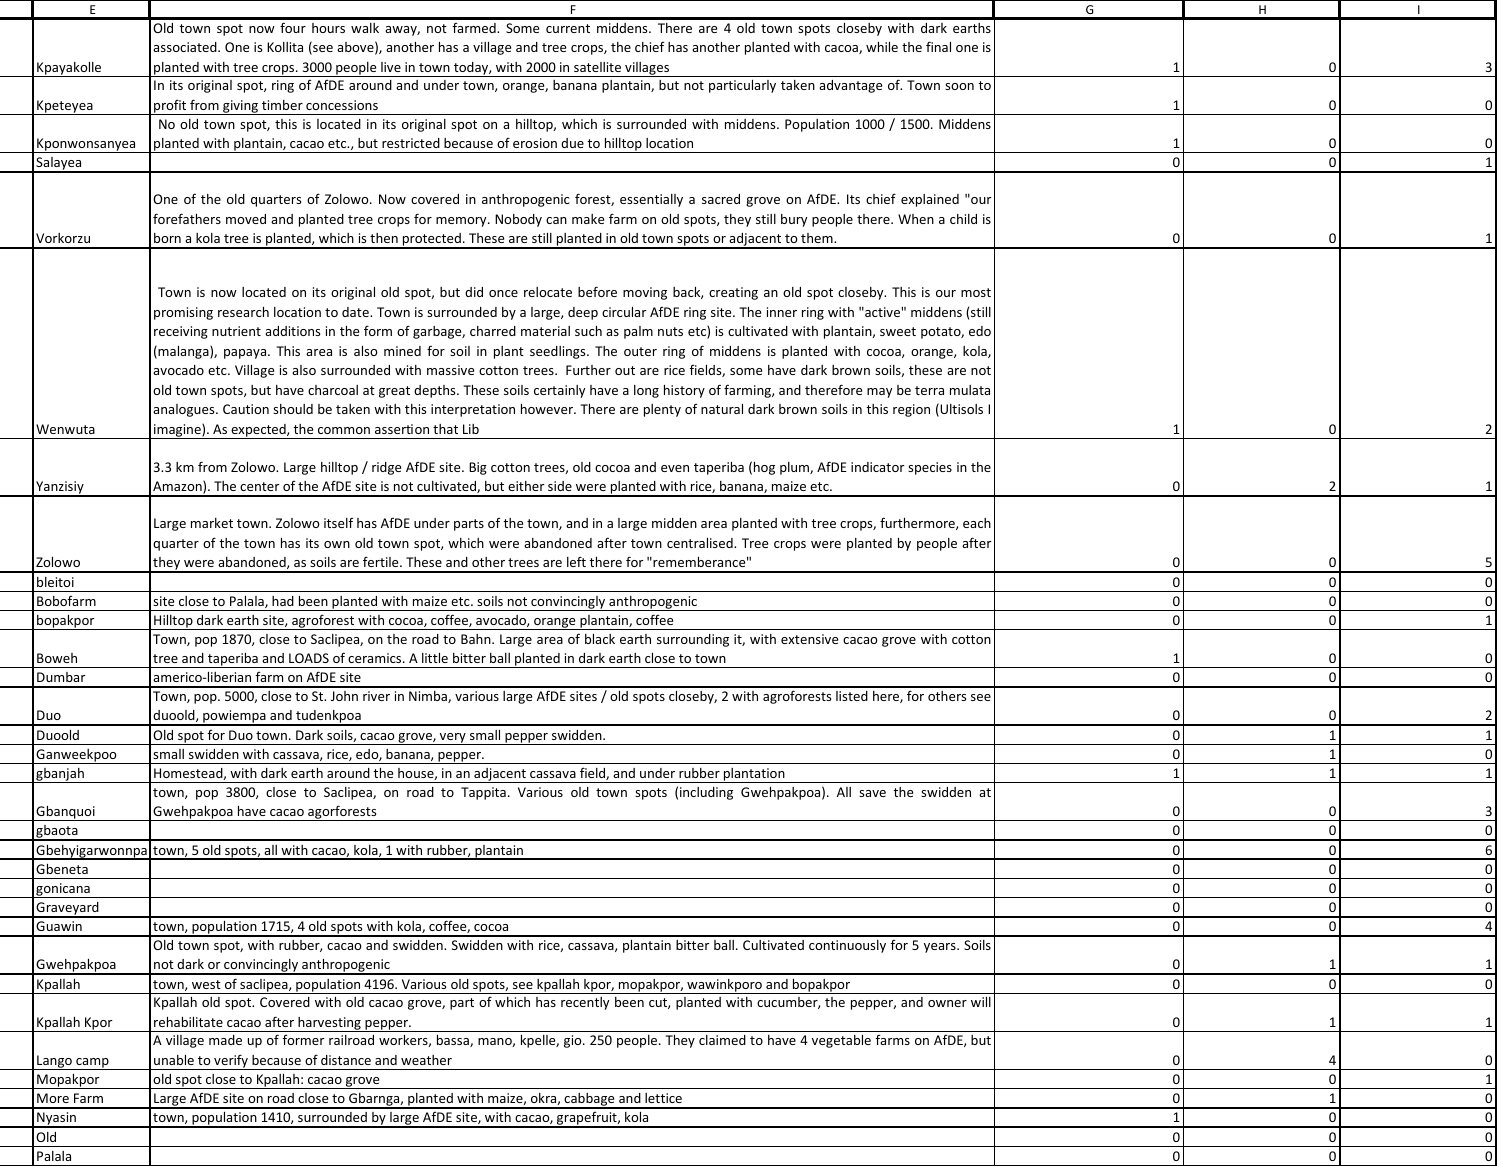
town, population 1410, surrounded by large AfDE site, with cacao, grapefruit, kola